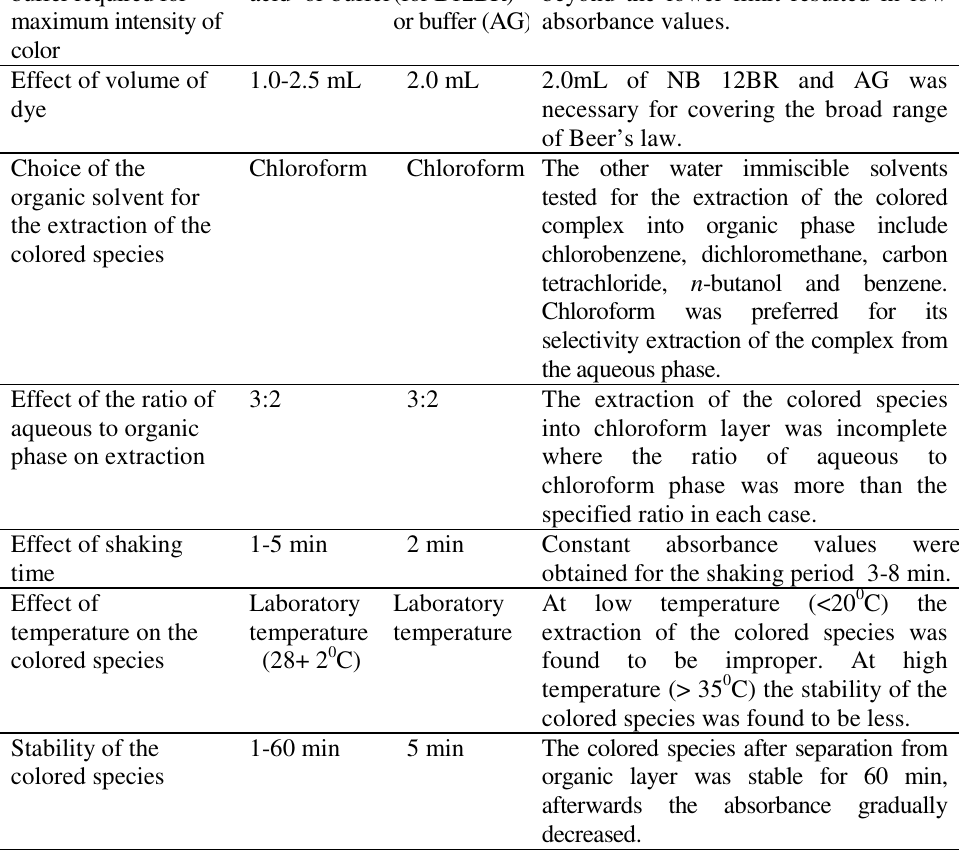
Table 3. Optical, regression characteristics of the proposed methods for